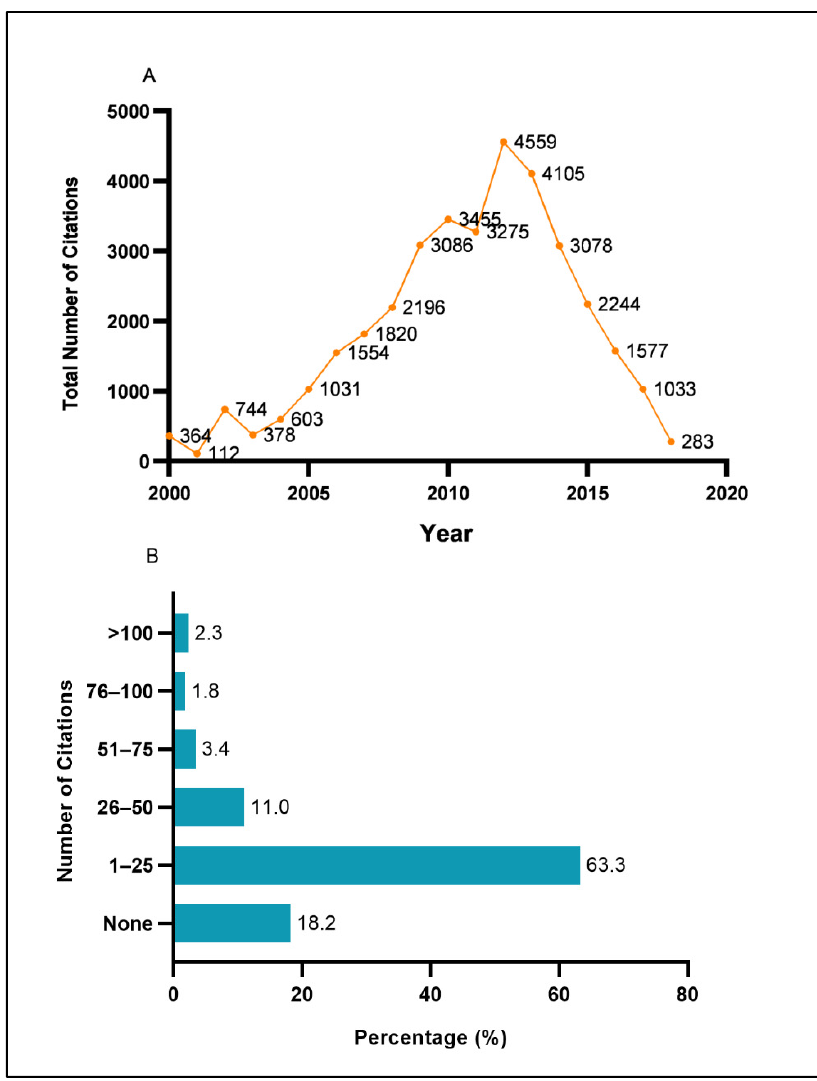
Figure 5. Citations analysis: ( A ) trend of the citations from 2000 to 2018 and ( B ) frequency of citations by range.